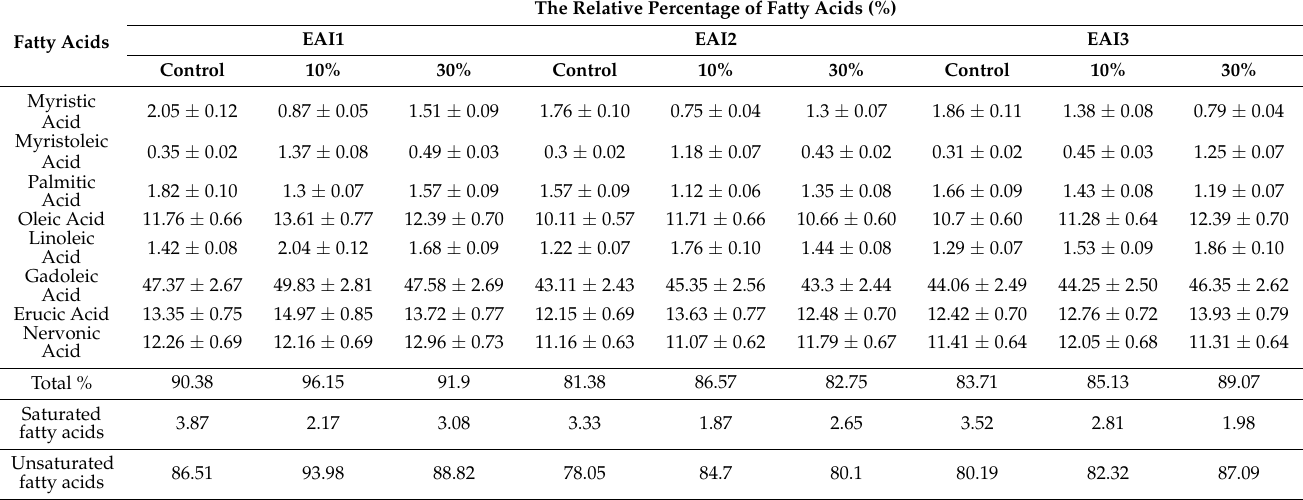
Table 6. The relative percentage of fatty acids (%) of the fixed oil of jojoba oil as influenced by combined treatments of plant genotypes and foliar application of Azolla filiculoides Lam. plant